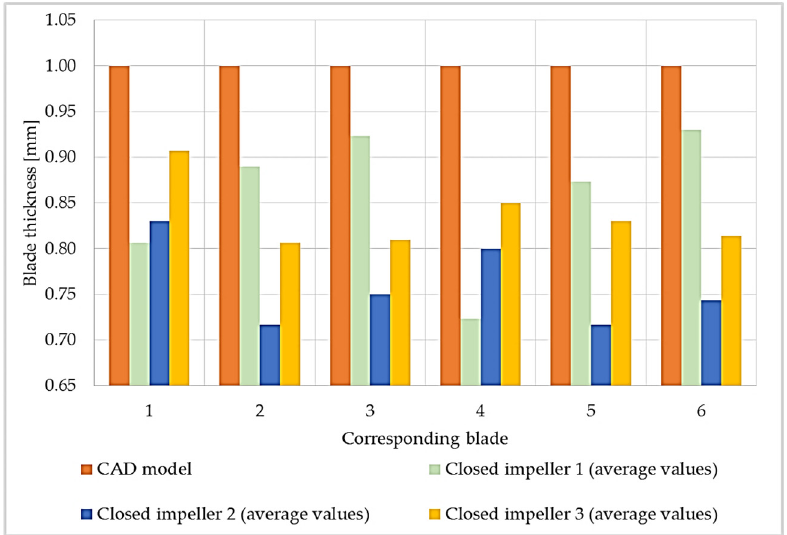
Figure 13. Blade thickness values measured using a caliper with an average of 3 values after AFM process values with respect to CAD model.